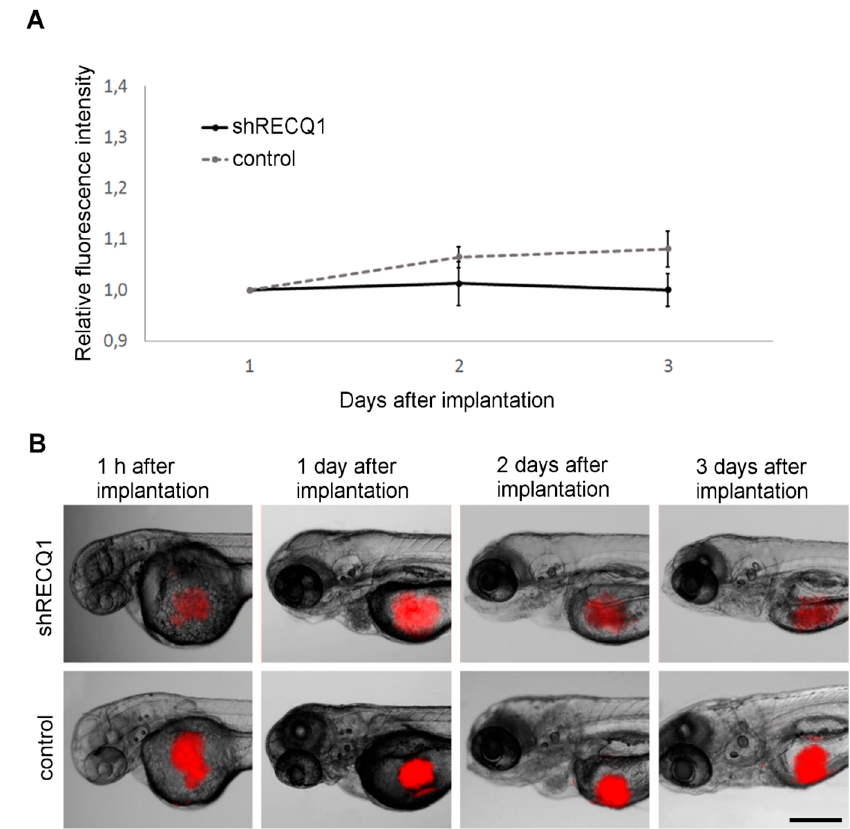
Figure 4. Xenotransplantation of U87 DsRed cells in the yolk sac of zebrafish embryos. ( A ) Changes in DsRed fluorescence in the yolk sac between day 1 and day 3 after implantation. Means ± SE are shown. No significant increase in fluorescence intensity was observed in RECQ1-silenced or in the control U87 cells; ( B ) Sequential images of xenotransplants in the yolk sac of zebrafish embryos between 1 h and 3 days after implantation. Scale bar: 250 µm.